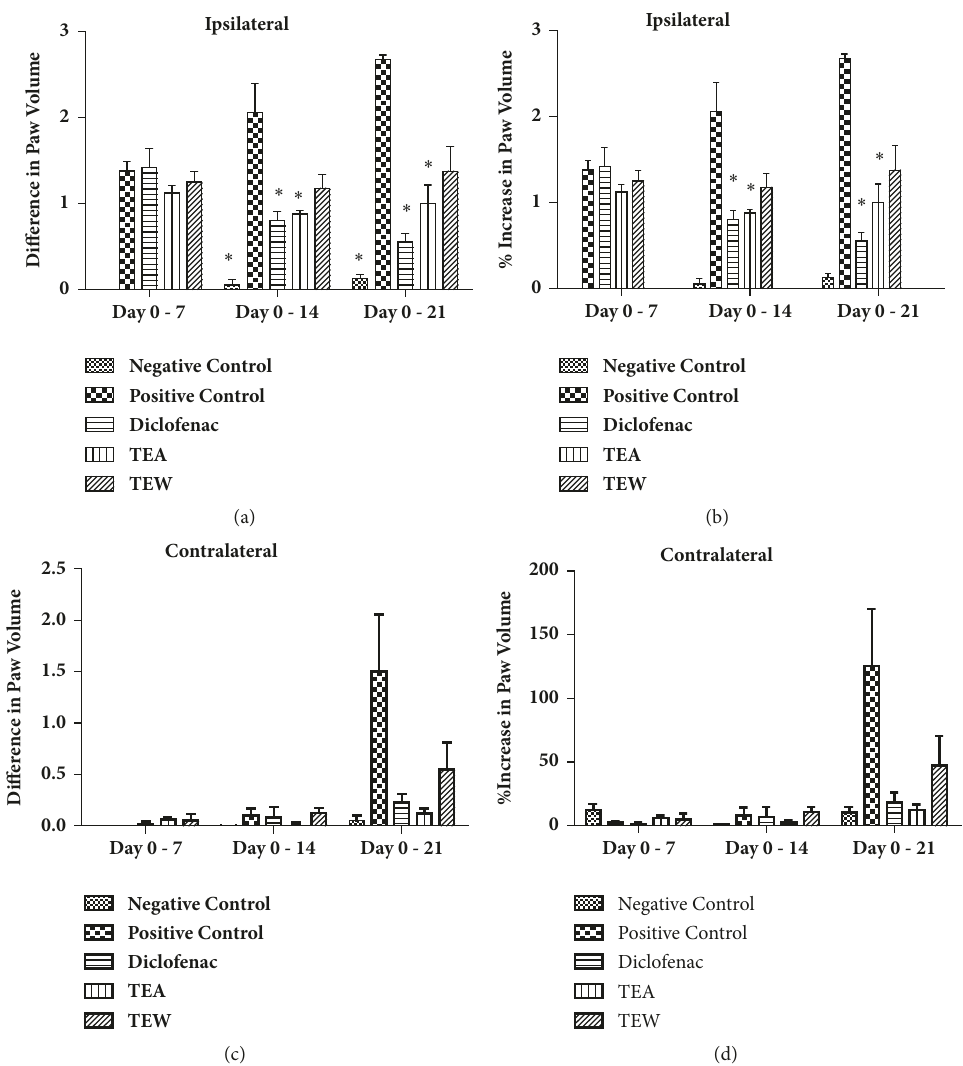
Figure 5: Complete Freund’s Adjuvant-induced arthritis in Wistar rats. Diclofenac sodium was used as a standard drug and the effect of ethanolic and water extracts of T. tomentosa was compared with disease